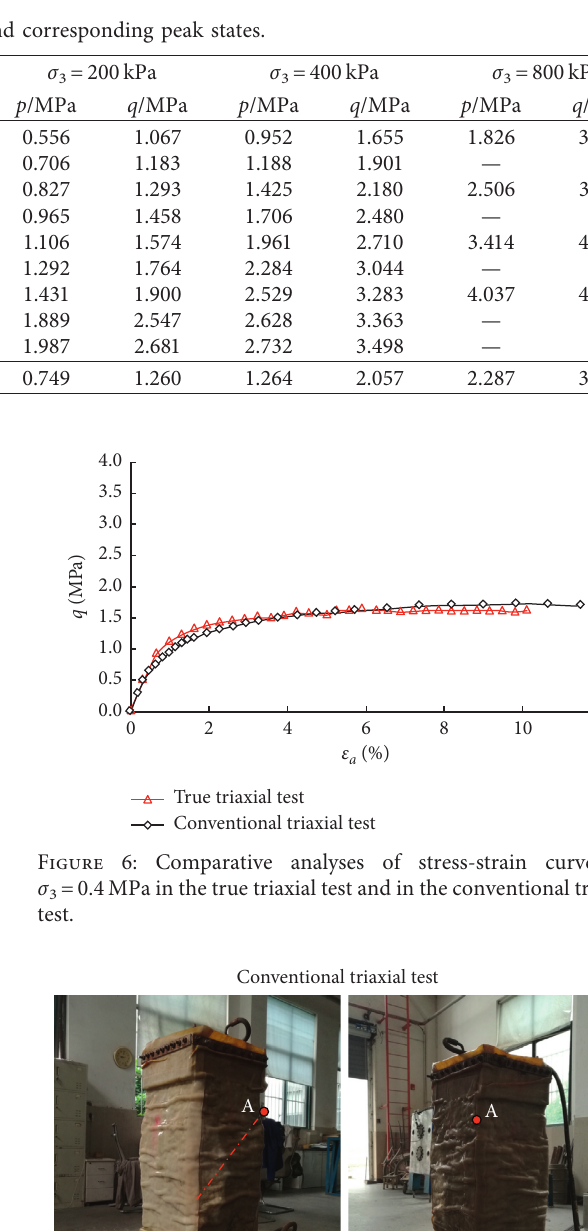
Mohr circles of the material under three different confining pressures are plotted in Figure 13. The Mohr circles are well